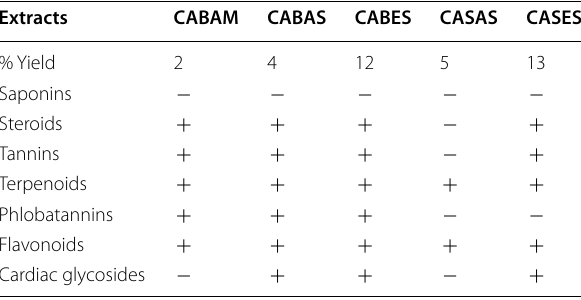
Table 1 Percentage yield and phytochemical constituents of C.